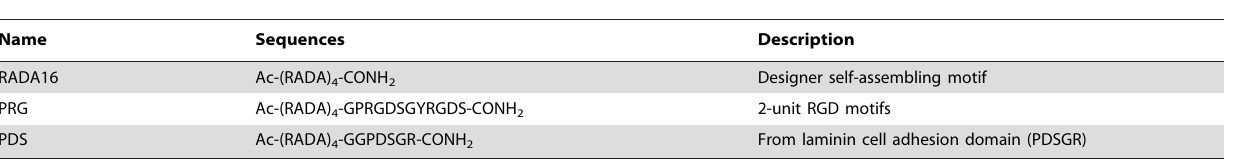
Table 1. Designer self-assembling peptides used in this study.